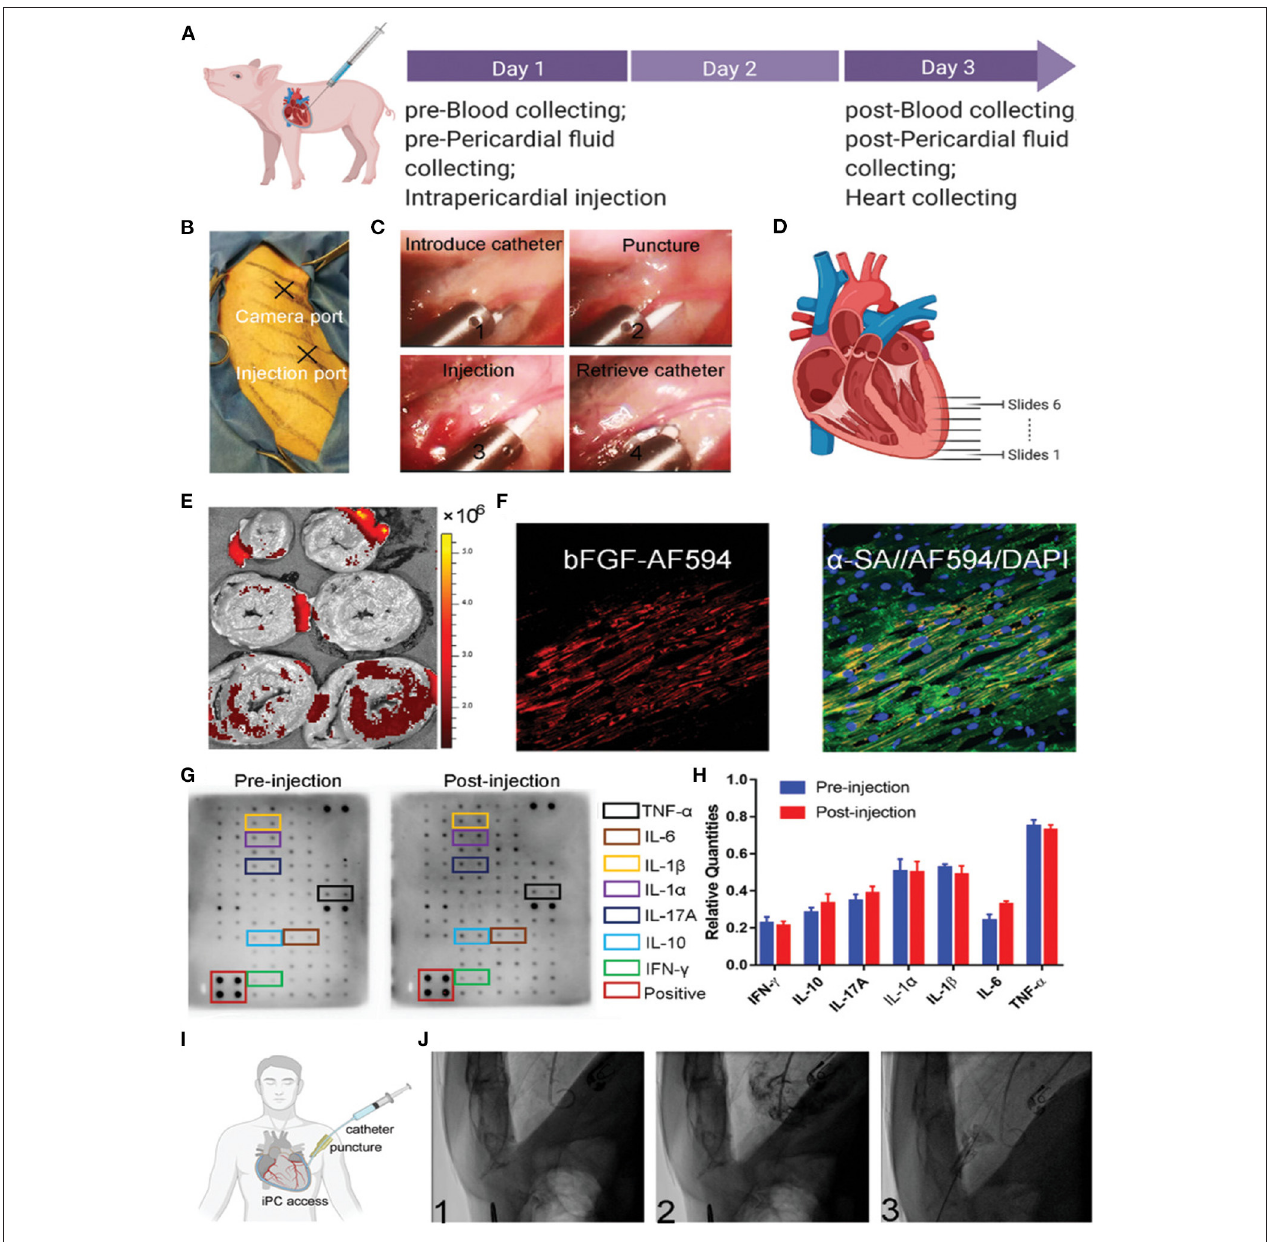
FIGURE 4 | (A) Schematics representing the protocol for large animal studies for smart hydrogel. (B) Photograph showing the position of the camera and an injection port. (C) Sequential representative images are displaying the administration of smart hydrogel. (D) Schematic representing the sectioning of the isolated heart. (E) Ex vivo NIR imaging of cardiac slices demonstrating the accumulation of injected smart hydrogel. (F) Fluorescence imaging of bFGF. (G,H) Quantitative and qualitative analysis of cytokines before and after administration of smart hydrogel. (I,J) The feasibility of minimally invasive catheter-based administration into the pericardial cavity in a human subject